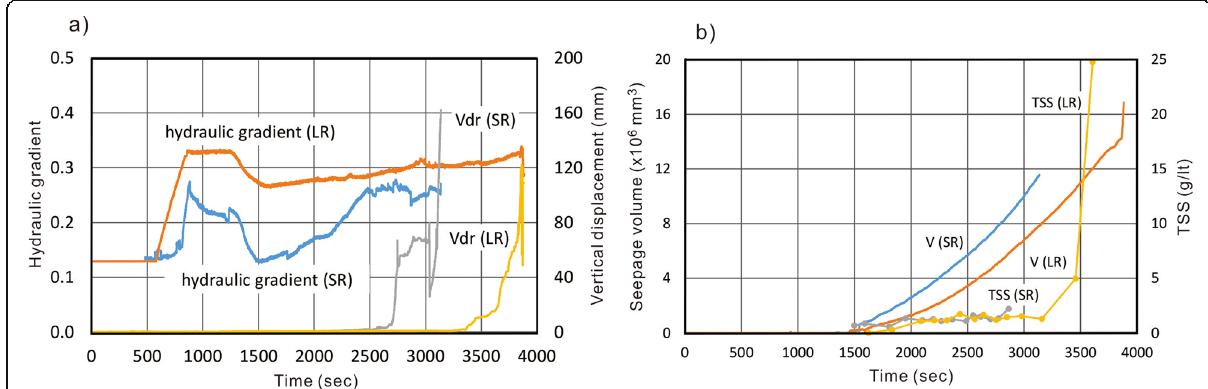
Fig. 8 Time series data of hydraulic gradient, vertical displacement, seepage volume and TSS for the sample S4568 at a small reservoir (SR) and large reservoir (LR). a Hydraulic gradient and vertical displacement; b Seepage water volume and